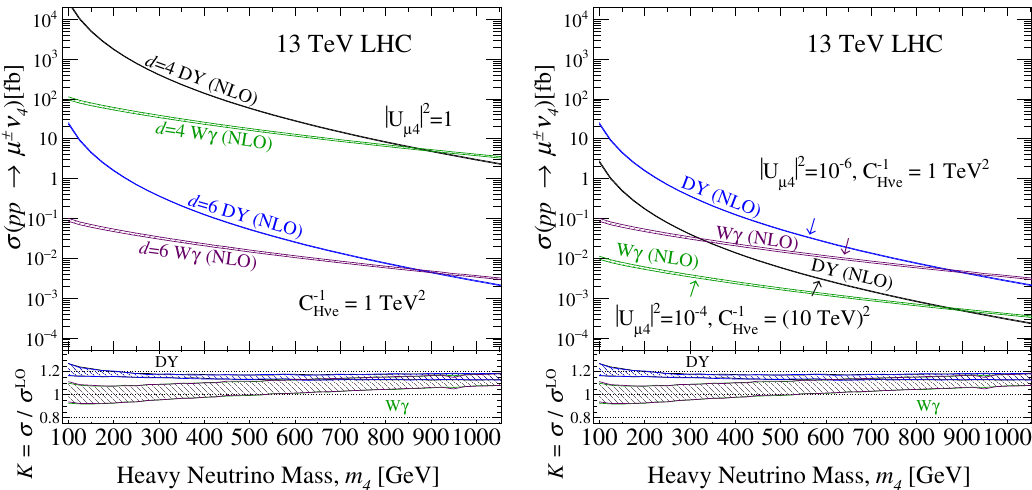
Figure 4 . (L) Upper: as a function of ν 4 ’s mass, the total pp → µ ± ν 4 + X cross section at √ NLO in QCD with scale uncertainty (band thickness) at the s = 13 TeV LHC for the Drell-Yan (DY) and Wγ fusion channels purely at dimension d = 4 assuming | U µ 4 | 2 = 1 (upper curves), and (cid:2) (cid:3) purely at d = 6 assuming C Hνe = (1 TeV) − 2 (lower curves). Lower: the QCD K -factor. (R) 4 µ Same as (L) but for the combined d = 4 + 6 rate assuming (upper curves) | U µ 4 | 2 = 10 − 6 with (cid:2) (cid:3) (cid:2) (cid:3) C Hνe = (1 TeV) − 2 and (lower curves) | U µ 4 | 2 = 10 − 4 with C Hνe = (10 TeV) − 2 4 µ 4 µ